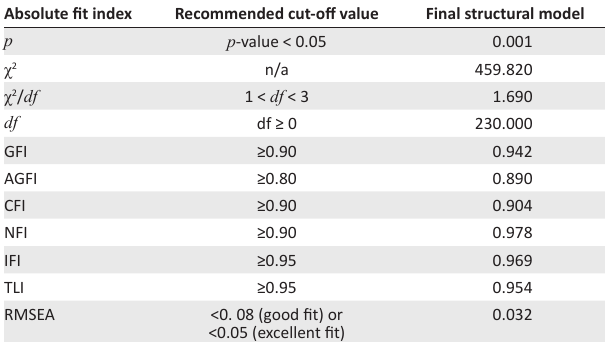
TABLE 3: Structural model fit summary of the proposed model. Absolute fit